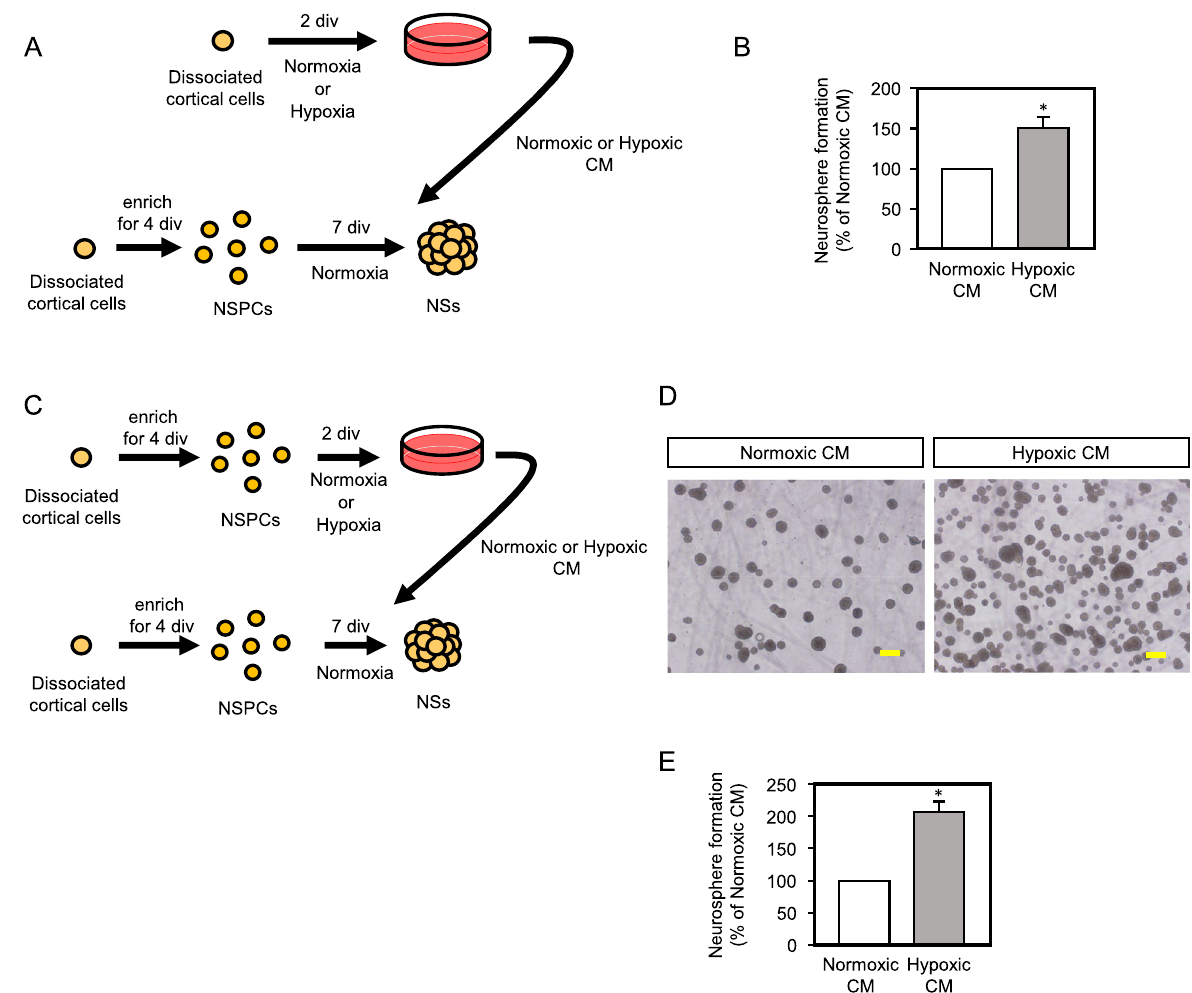
Fig. 2. NSPCs secret factor(s) enhancing neurosphere formation in an autocrine manner under hypoxic condition. A Experimental procedure of (B). The CM was harvested from E14.5 cortical cell culture for 2 days under the normoxic or the hypoxic condition. Neurosphere formation derived from E14.5 enriched NSPCs was performed under the conventional normal condition with CM. B Quantification of the neurospheres formed under the CM (mean SEM, n 4, * p 0.0355). C Experimental procedure of (D)-(E). The CM was harvested from enriched NSPC culture for 2 days ± = = under the normoxic or the hypoxic condition. Enriched NSPCs was cultured under the CM from the normal O 2 atmosphere. D Microphotographs of neurospheres formed under the CM from the normoxic or the hypoxic enriched NSPC culture. Scale bar 200 μm. E Quantification of the = neurospheres formed under the normoxic or the hypoxic CM (mean SEM, n 3, * p ± = =